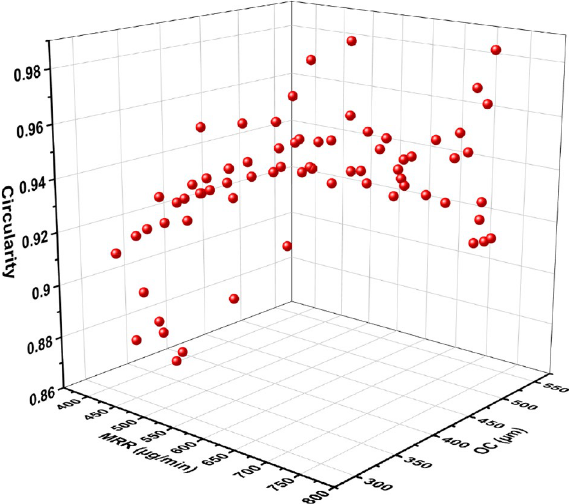
Figure 13. Pareto-optimal solutions obtained by the MO-JAYA